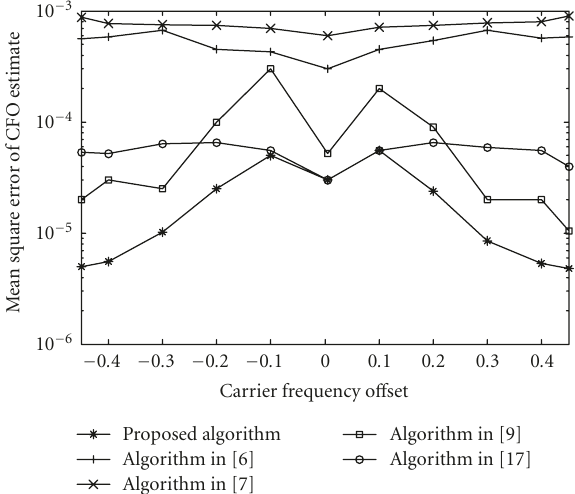
Figure 2: Average of CFO estimate (SNR = 20 dB, g = 1dB, and θ = 15 ◦ ).